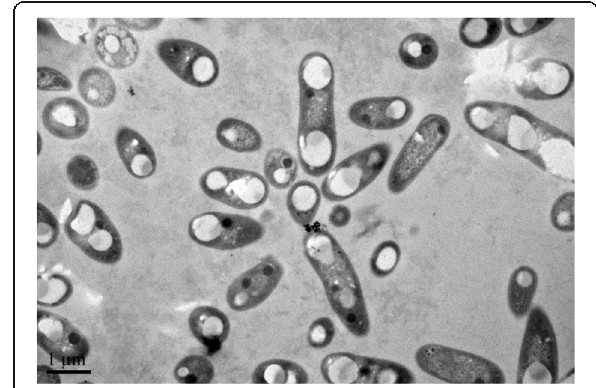
Fig. 2 Micrography of the Methylobacterium sp. XJLW under transmission electron microscope (15,000 ×, HITACHI H-7650